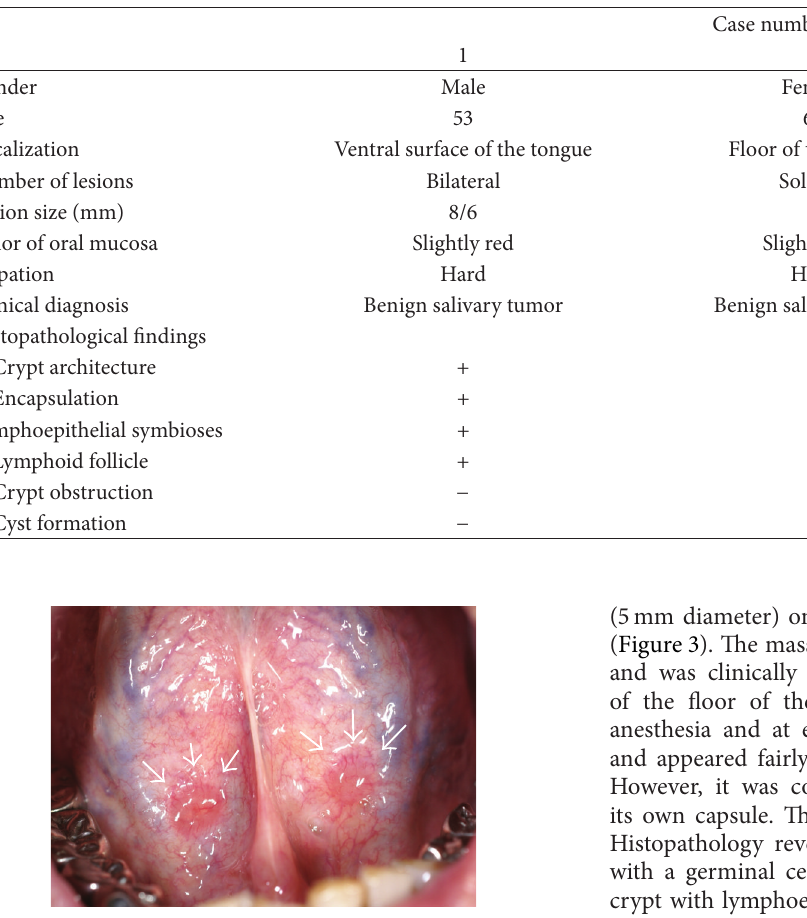
Figure 1: Clinical findings of Case 1. Small, bilaterally symmetric masses on the ventral surface of the tongue